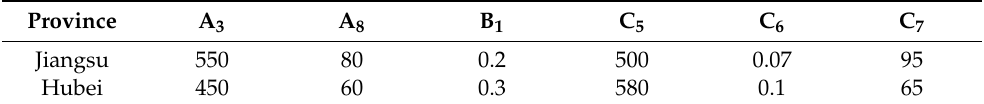
Table 5. Data for key variables.